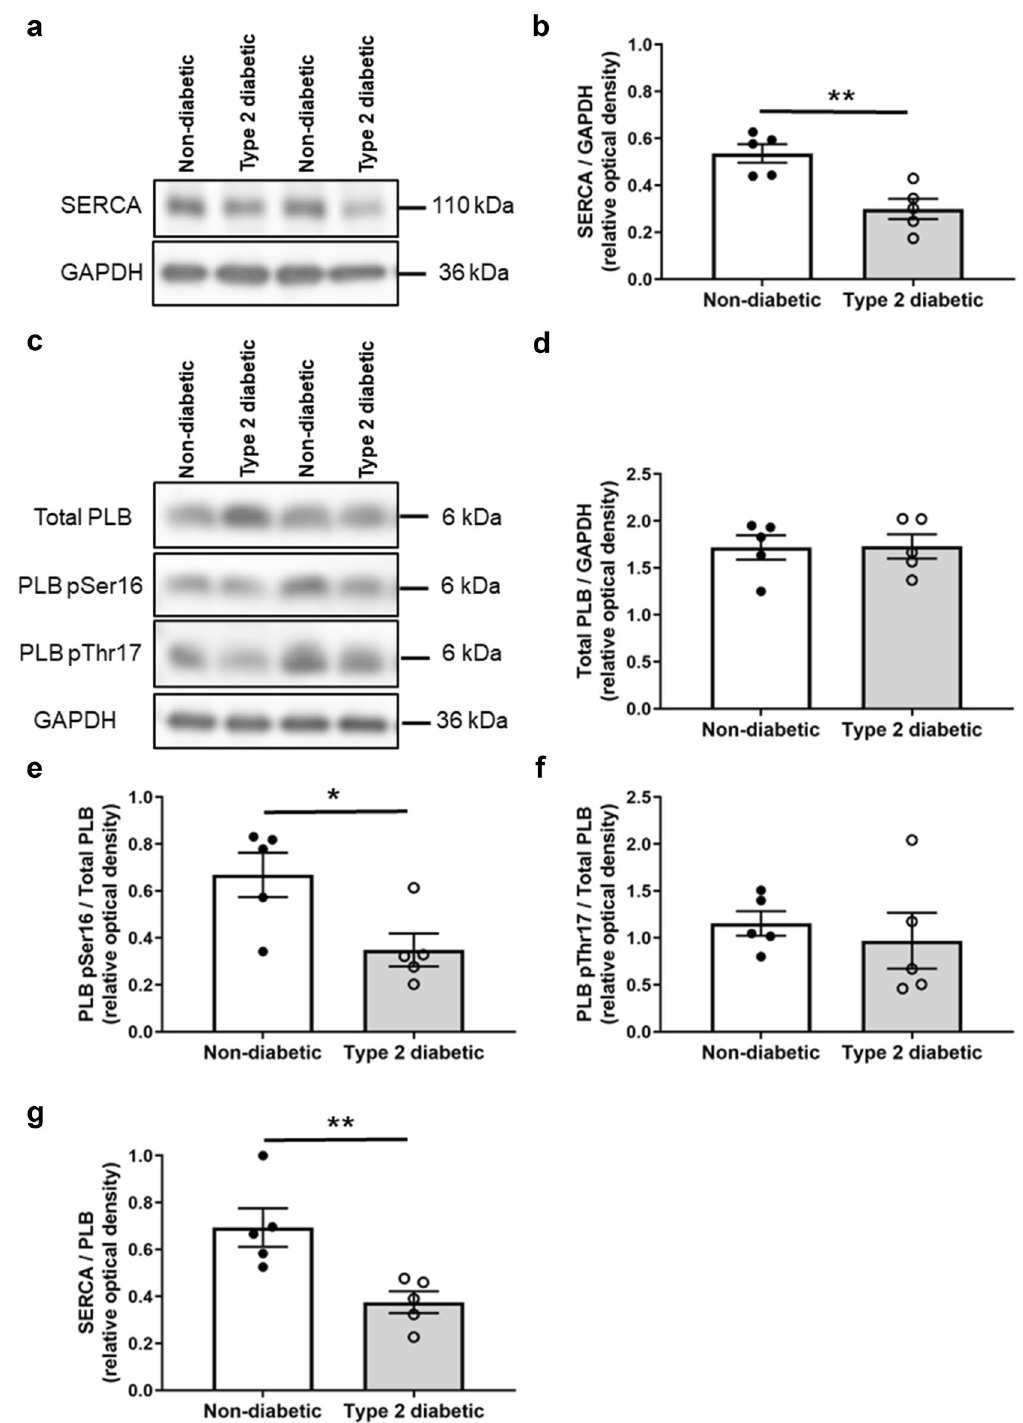
Figure 3. Protein expression of SERCA, phospholamban, and phosphorylated phospholamban at Ser16 and Thr17 in non-diabetic and diabetic rat left ventricular tissues. ( a ) Representative immunoblots of SERCA and GAPDH. ( b ) Quantification of SERCA level in non-diabetic and diabetic hearts. ( c ) Representative immunoblots of total PLB, phosphorylated PLB at Ser16 (PLB pSer16) and Thr17 (PLB pThr17), and GAPDH as a loading control. Quantification of ( d ) total PLB levels, ( e ) phosphorylated PLB Ser16, and ( f ) phosphorylated PLB Thr17 levels in non-diabetic and diabetic hearts. ( g ) SERCA/PLB ratio in non-diabetic and diabetic hearts. Data shown are means ± SEM, obtained from duplicate blots, * P < 0.05, ** P < 0.01 versus non-diabetics, unpaired t-test. Original immunoblots are presented in Supplementary Fig